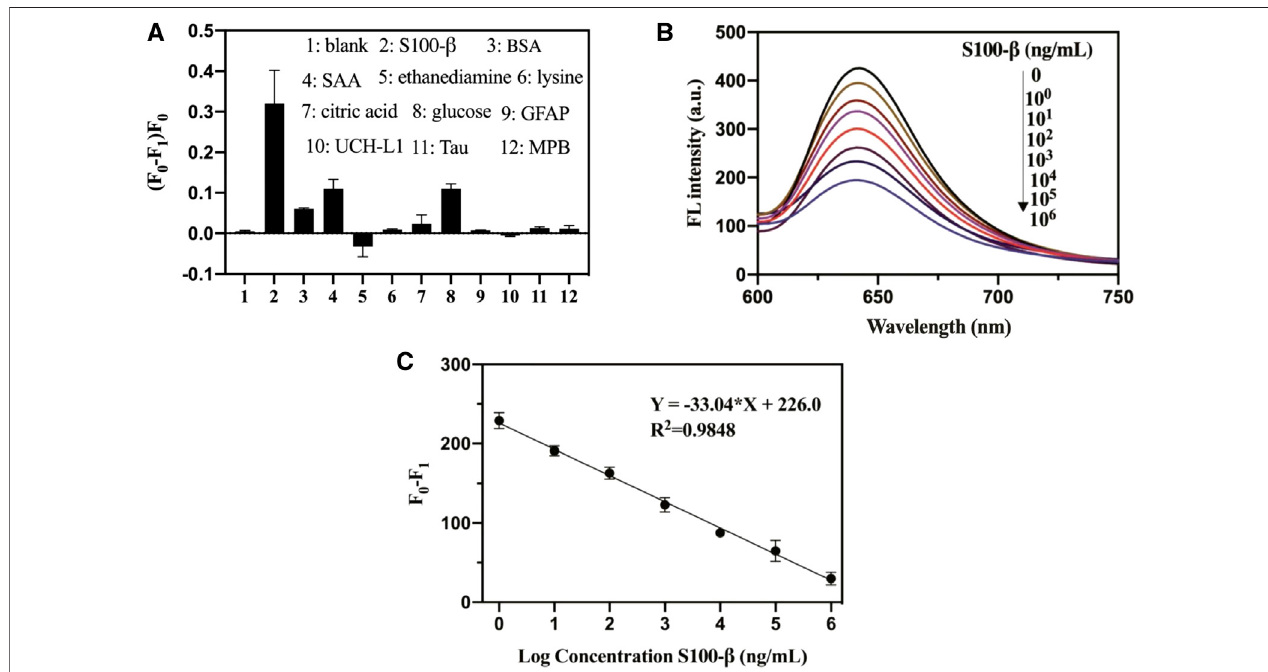
FIGURE 2 | (A) . Speci fi city of pep-CPDs for S100- β over interferents. The concentrations of S100- β and interferents were 10 3 ng/ml. (B) . Relationships between fl uorescenceintensityofpep-CPDsandS100- β from0to10 6 ng/ml. (C) .Calibrationcurveoftherelated fl uorescenceintensity(F0-F1)versustheconcentrationoftarget S100- β . F 0 and F 1 represent the fl uorescence intensity of the nanoprobe in the absence and presence of target S100- β